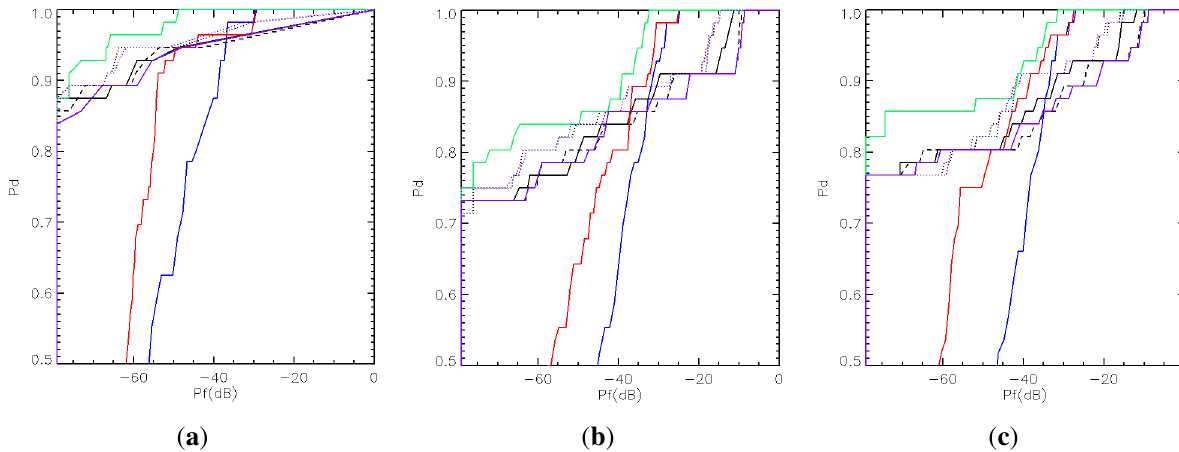
Figure 6. Detector ROC curves for sub-look analysis in the range direction. RADARSAT-2 fine quad-pol data. Boxcar filter: 3 × 5 (range × azimuth) pixels. ( a ) HV channel; ( b ) HH channel; ( c ) VV channel. Vessels analyzed: 69; pixels used for P sub-look correlation (solid: filtered with no overlap; dashed: filtered 30% overlap); blue: sub-look coherence; green: GLRT; violet: intensity (dotted: no average; solid: averaged); red: sub-look entropy.